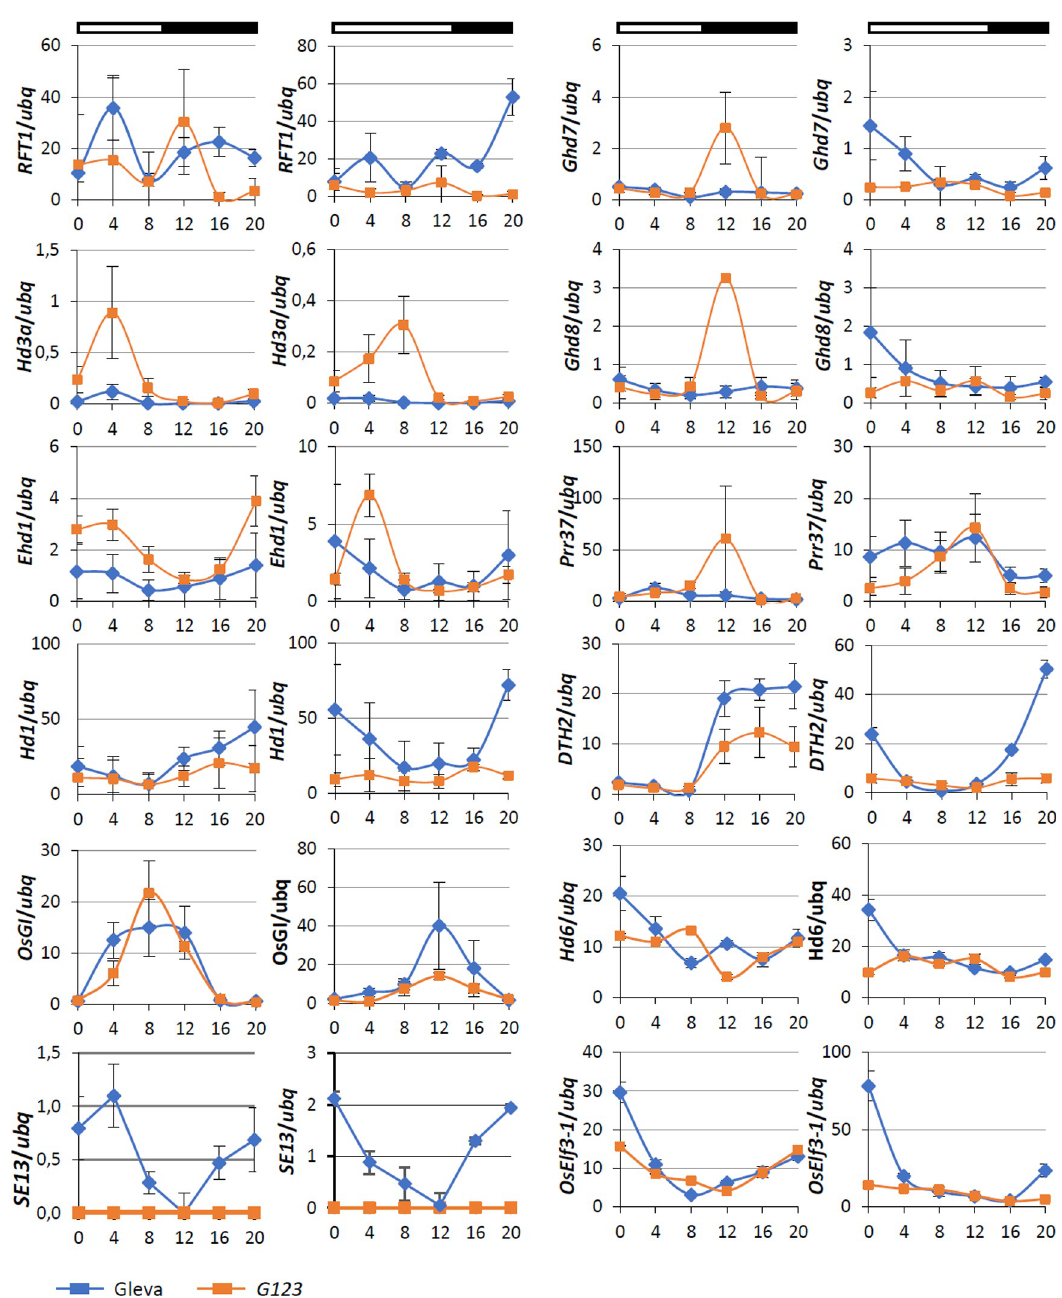
Fig 3. Diurnal expression patterns of flowering regulatory genes in Gleva and G123 . Plants were grown under 12 h light:12 h dark day conditions for 4 weeks, followed by an additional 1-week period under LD or SD conditions. White and black horizontal bars represent the light and dark periods, respectively. Each value is the average of three biological replicates. Error bars indicate standard deviation from the mean.